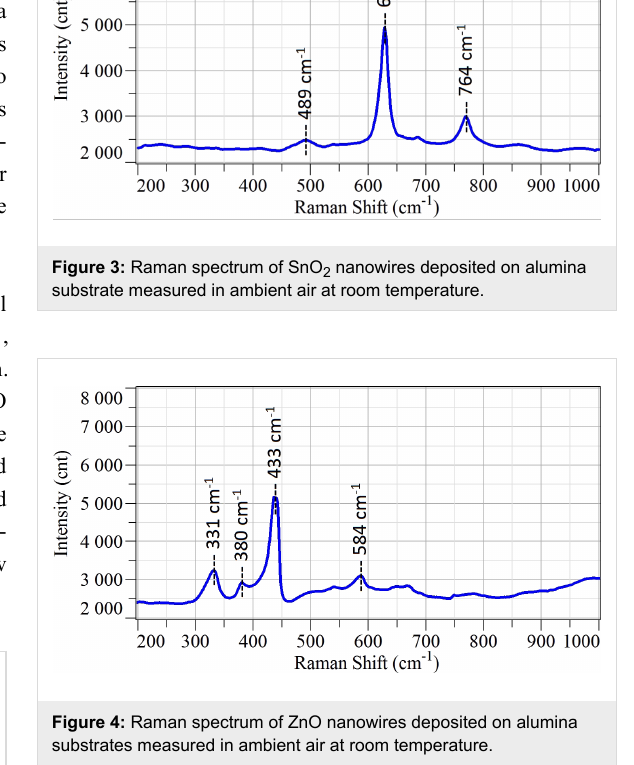
Thermal oxidation technique: WO 3